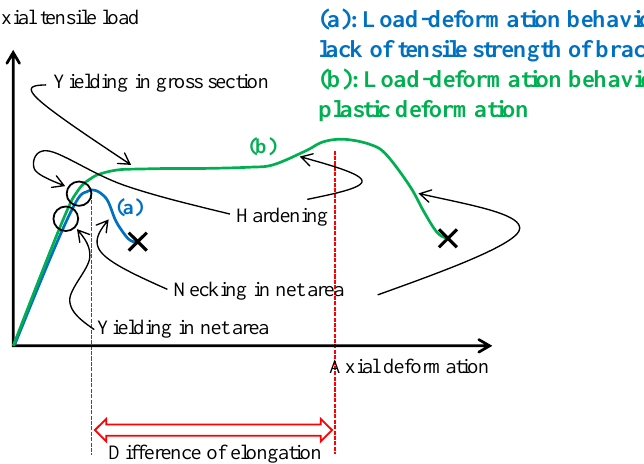
Figure 4. Load–deformation relations with or without plastic deformation.